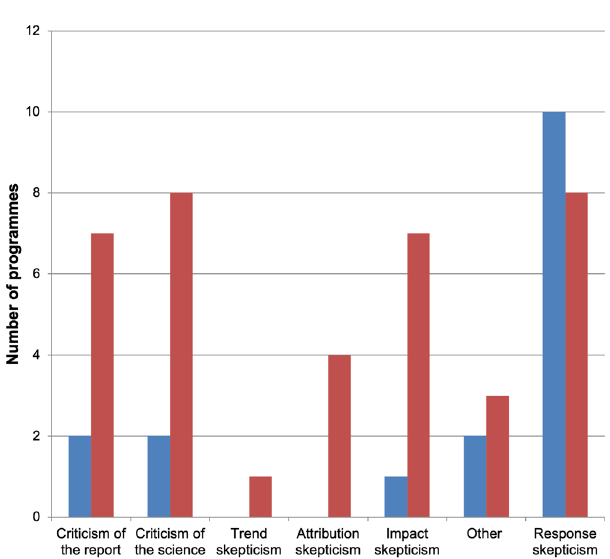
Fig. 1 Presence of forms of skepticism in mainstream and right-wing channels. Mainstream channels in blue and right-wing channels in